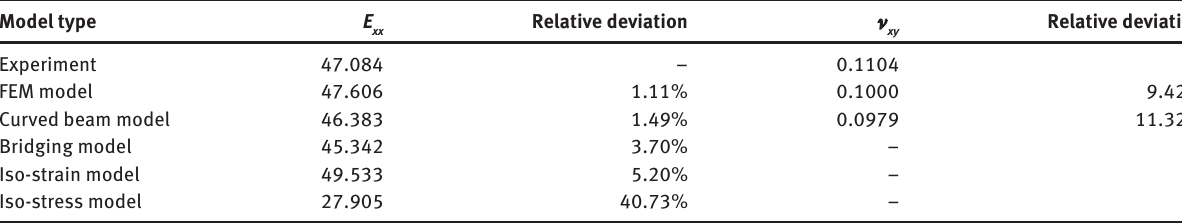
Table 6: Comparison between experiments and predictions in different